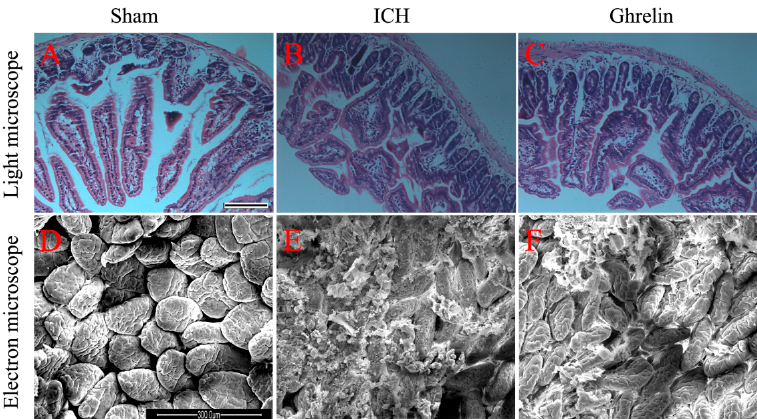
Figure 1. Ghrelin attenuated intestinal mucosal injury after intracerebral hemorrhage (ICH). ( A ) The sham group showed nearly intact mucosa at the histomorphometric level. Scale bar = 100 µm; ( B ) The ICH group presented severe lifting of epithelial cells, thickened and shortened villi, fusion of adjacent villi, and naked lamina propria at the histomorphometric level; ( C ) Less lifting of epithelial cells, thinner and longer villi, less fusion of adjacent villi and naked lamina propria were observed in the ghrelin-treated group at the histomorphometric level; ( D ) The sham group showed smooth-surfaced, orderly arranged villi with few secretions at the ultrastructural level. Scale bar = 300 µm; ( E ) ICH induced marked ultrastructural changes, including increased secretions, irregularly arranged, thickened, sparse, and surface-ruptured villi; and ( F ) Less secretions and more intact villi were observed in the ICH + ghrelin group at the ultrastructural level. n = 4 per group.